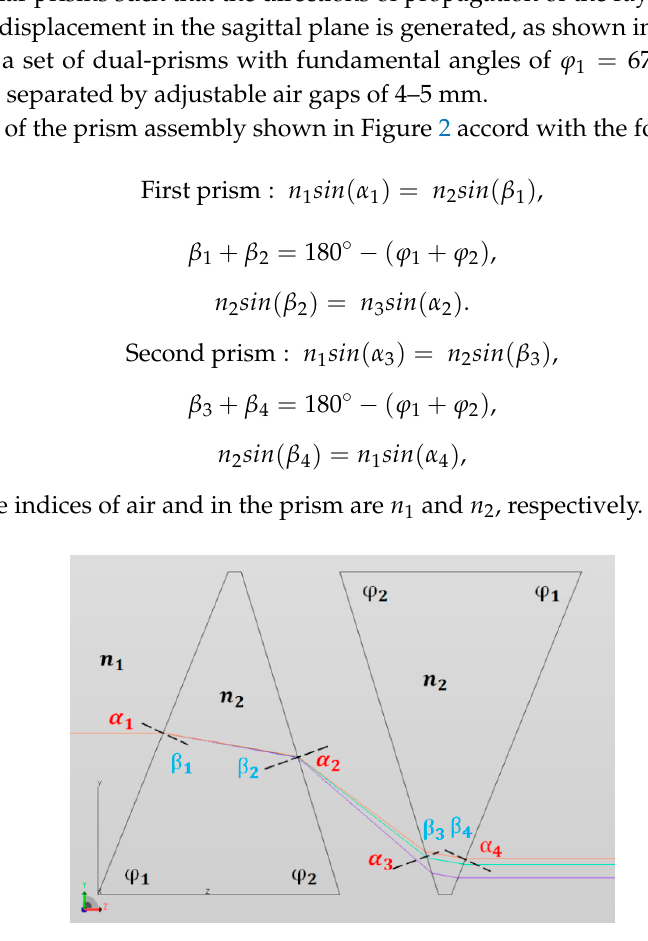
Figure 3. On-axis ray propagations of the dual-prism system for prism angles φ 1 and φ 2 . Note that the on-axis exit ray is parallel with that of the incoming ray; and the 3 colored rays (purple, green, and red) represented the short (450 nm), mid (550 nm) and long (700 nm) wavelengths, respectively.